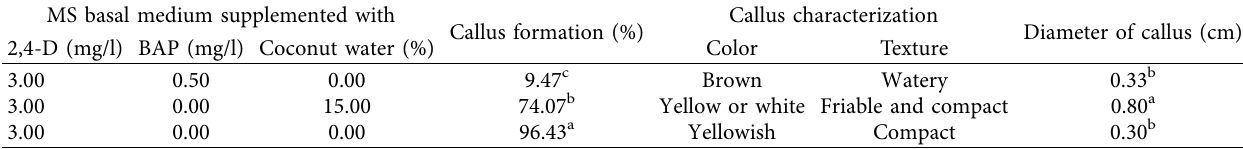
Table 1: Effect of culture medium on callus induction, characterization, and growth after culture for 4 weeks. MS basal medium supplemented